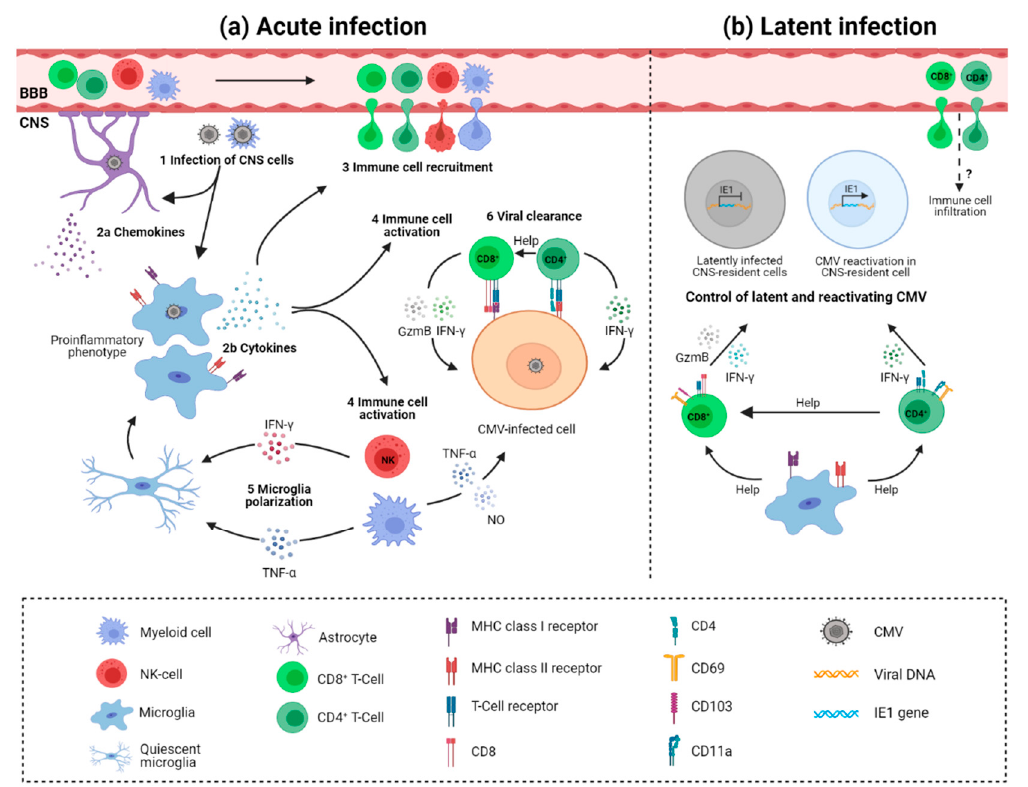
Figure 2. Immune response to cytomegalovirus infection in the brain. ( a ) Acute infection. Upon crossing of the blood–brain barrier (BBB), cytomegalovirus (CMV) infects resident cells (1). Astrocyte-derived chemokines recruit microglia to the infection site (2a). Microglia are activated via pattern recognition receptors and cytokines. Activated microglia produce proinflammatory cytokines (2b), which mediate immune cell recruitment into the brain (3) and orchestrate immune cell response (4). Infiltrating NK cells and ILC1 cells produce IFN- γ and myeloid cells produce TNF- α , leading to